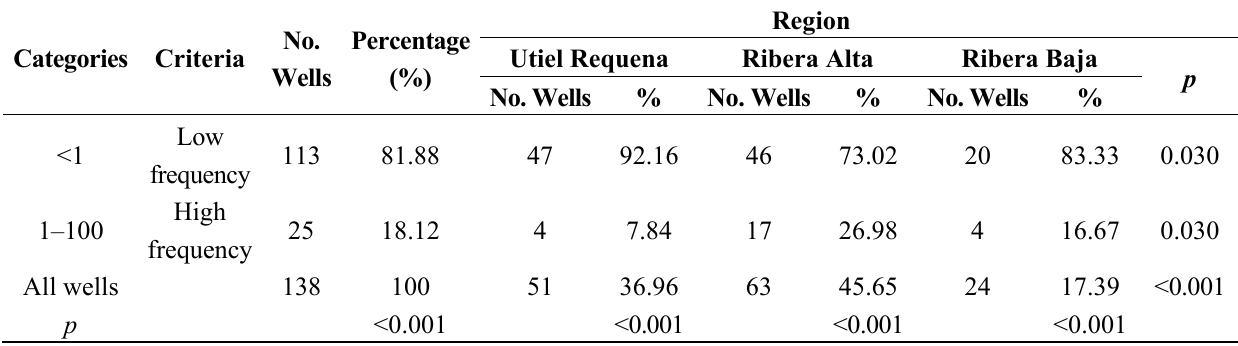
Table 1. Distribution of wells according to location and risk categories.